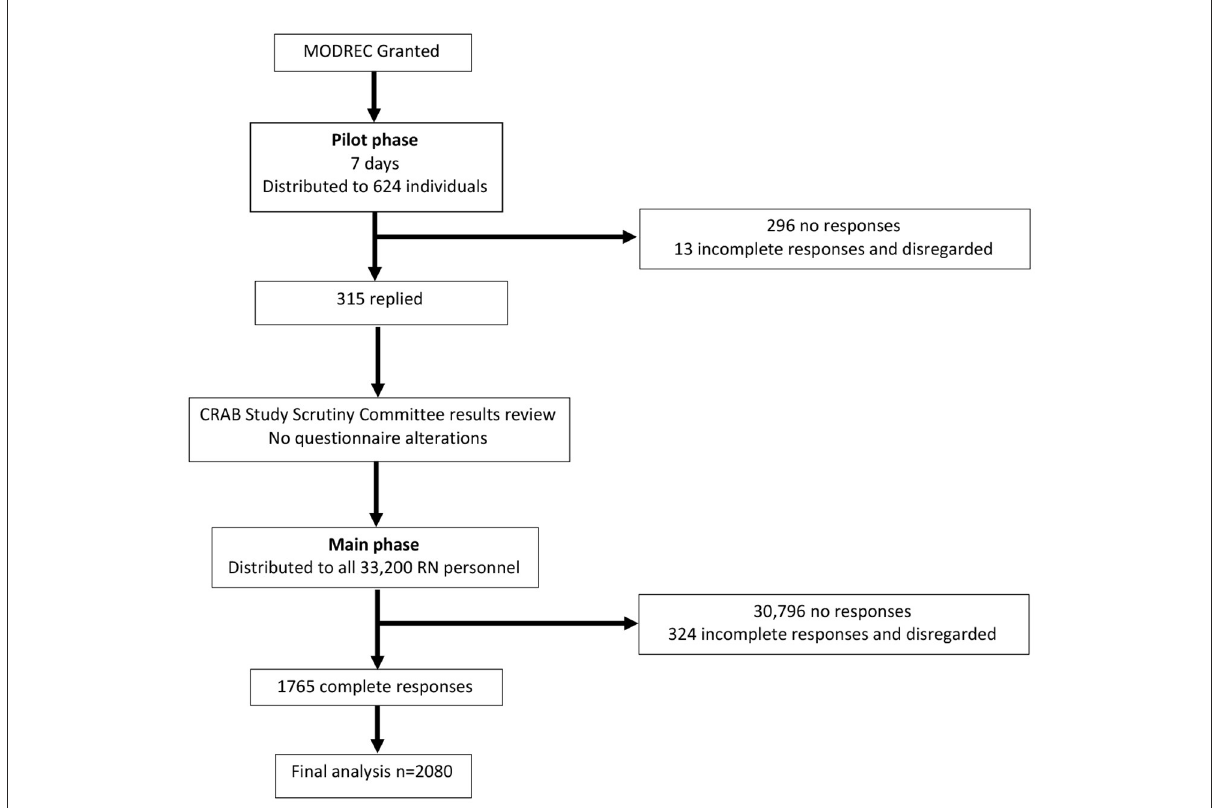
FIGURE1 Schema of study. n, number; MODREC, Ministry of Defence Research Ethics